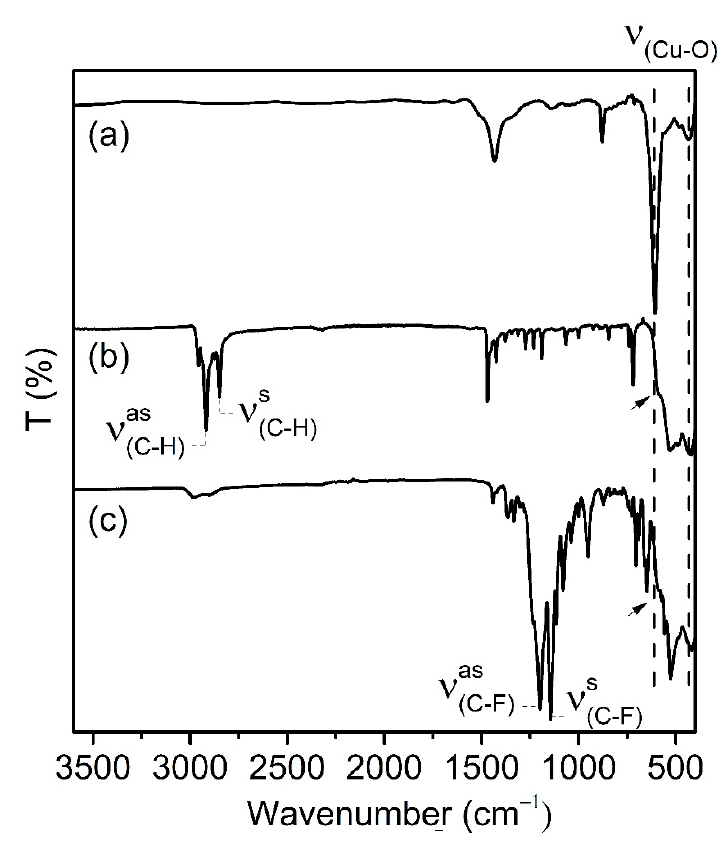
Figure 2. FT-IR spectra of ( a ) CuONPs, ( b ) CuONPs@CH, and ( c ) CuONPs@CF.